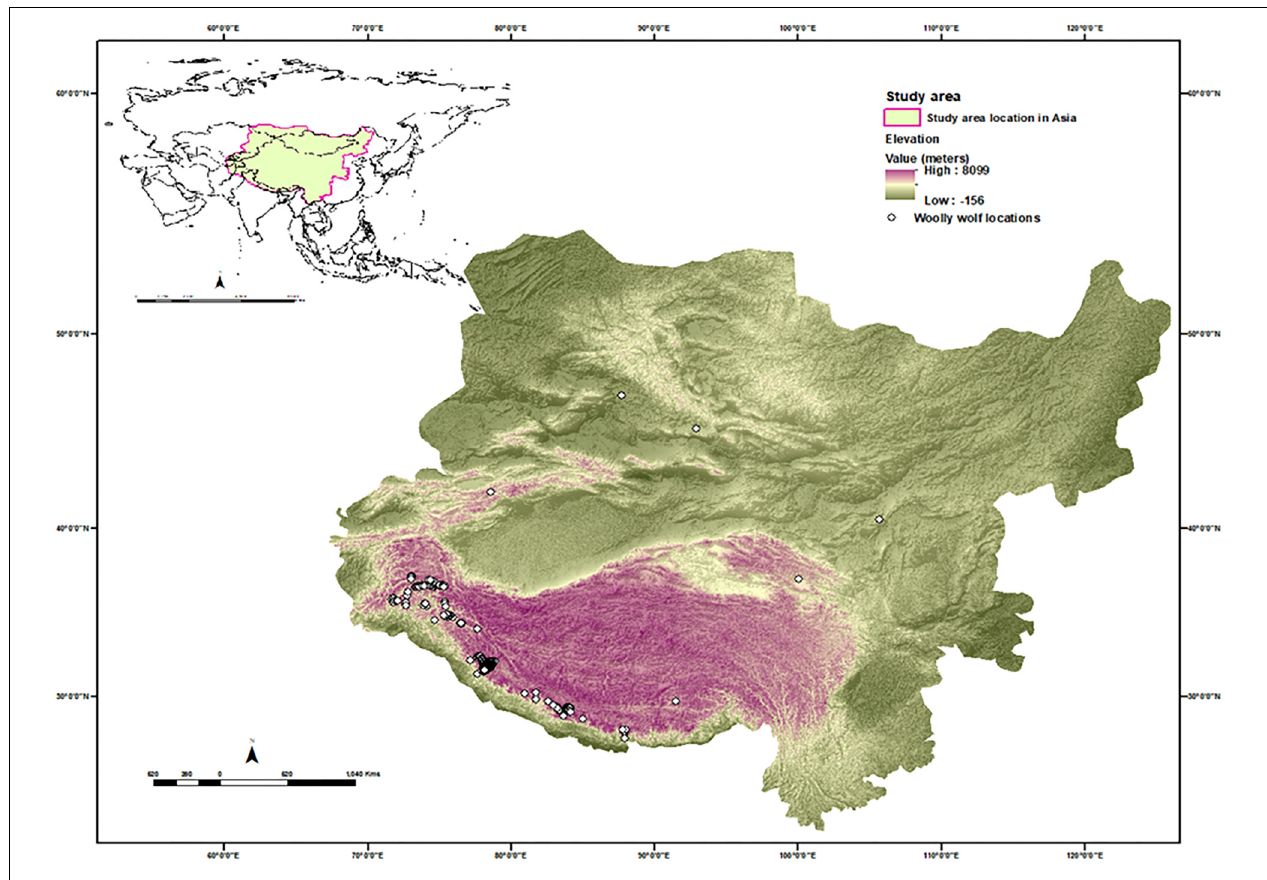
FIGURE 1 | Map of the study area along with collated presence locations used for distribution modeling of the wooly